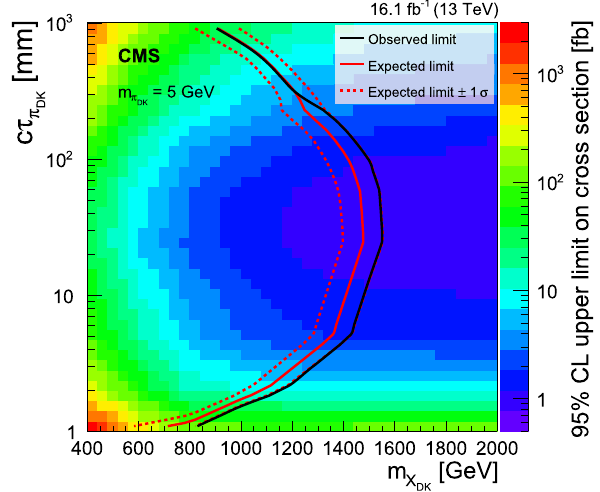
Fig. 9 95% CL limits on the cross section for pair production of (cid:10) versus m (cid:10) (here called leading to emerging jets, in the plane of c τ π D c τ π and m X ) where m π (here called m π ) is set to 5 GeV. Repro- DK DK D DK duced from Ref.